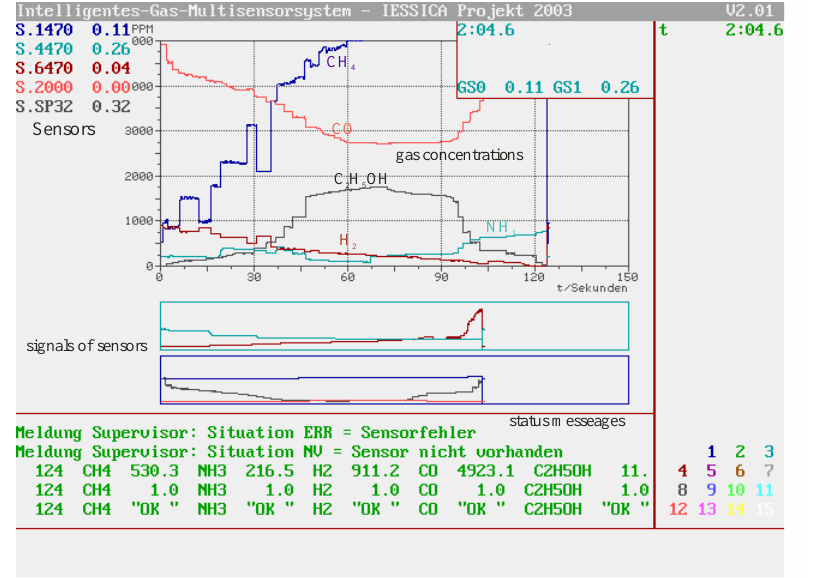
Figure 4. Simulation of the five semiconductor gas sensor array with the IGM-software for qualitative analysis. The sensors 1470, 4470, 6470, 2000 and SP32 are main sensitive to CH H OH, respectively. Gas concentrations are calculated from signals in Fig. 5 under consideration of C 2 5 the cross-sensitivities switched on by means of the flags f